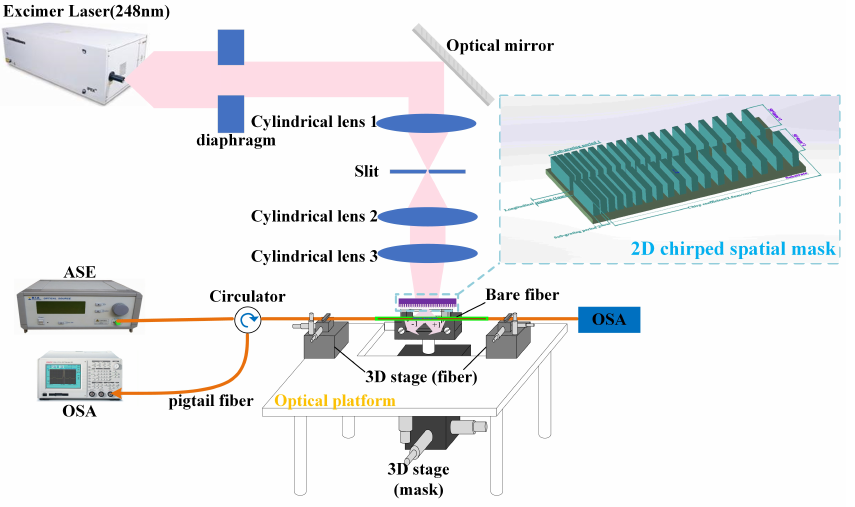
Figure 10. Schematic diagram of a system for inscribing 2D chirped fiber gratings based on a 2D chirped spatial mask.